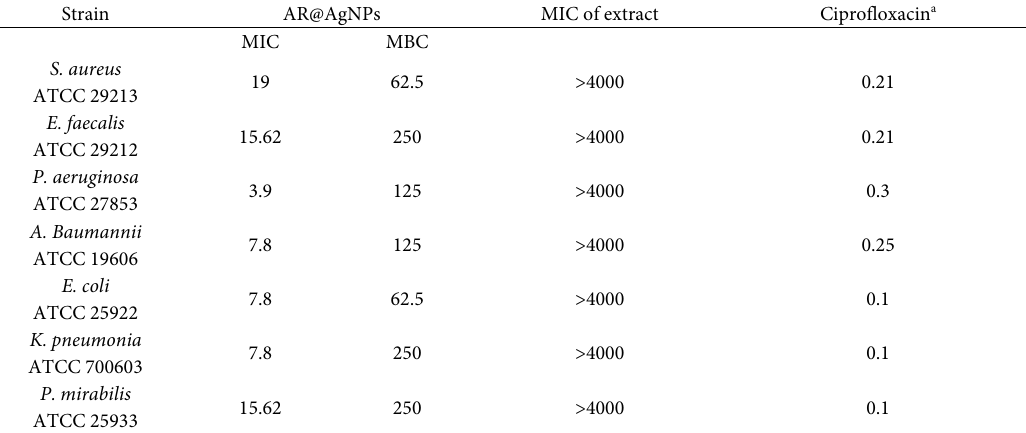
Table 1. Antibacterial activities of AR@AgNPs against ATCC bacteria